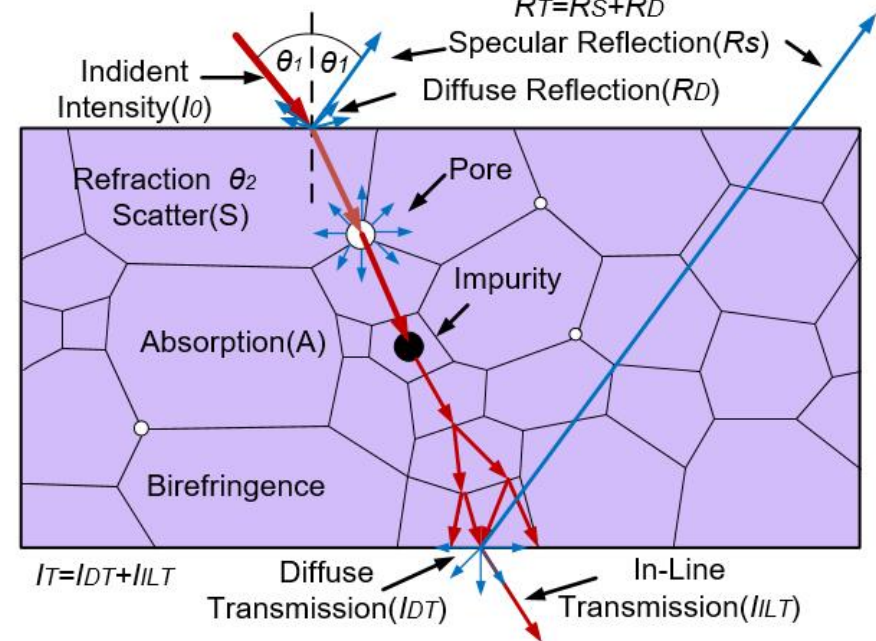
Figure 1. Sketch of light transmission in a polycrystalline ceramic.